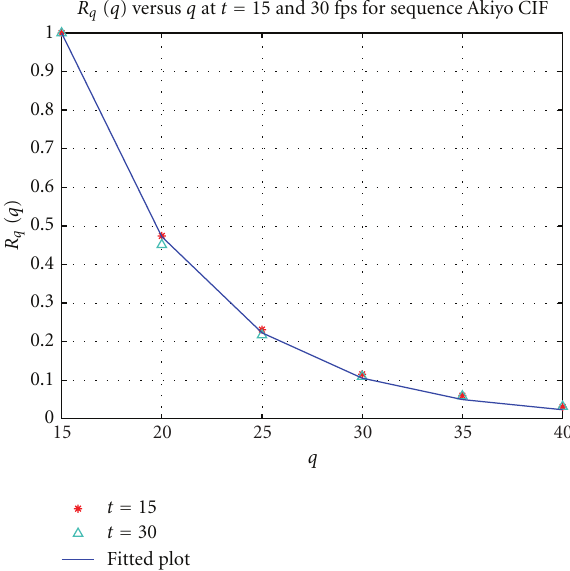
Figure 3: Normalized rate R q ( q ) versus q at t = 15, 30 fps for sequence Akiyo (CIF).